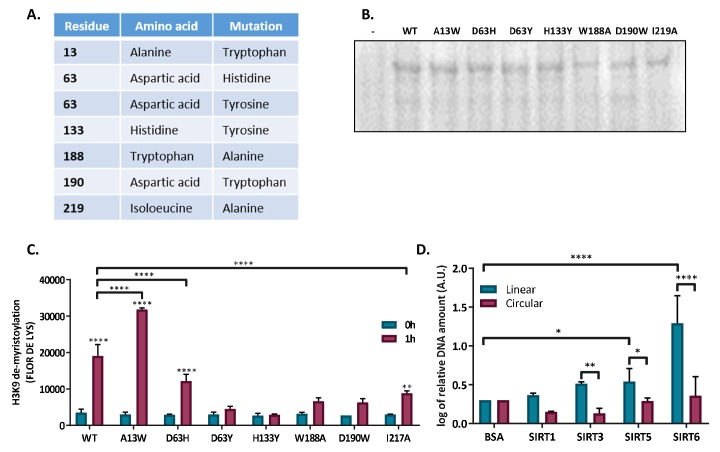
SIRT6 binds DSB through itscore domain.(A) List of generated SIRT6 point mutations in the SIRT6 tunnel structure. (B) Ponceau staining of SIRT6-MBP point mutants. (C) Catalytic activity of SIRT6-MBP mutants, assessed by H3K9 de-myristolation in a FLUOR DE LYS assay. (D) Ability of His-tagged mammalian Sirtuins to bind the DNA circular and linear plasmids. Data are logs of the averages from 4–7 experiments (with error bars representing SEMs) (*, p<0.05; **, p<0.005; ***, p<0.0005).